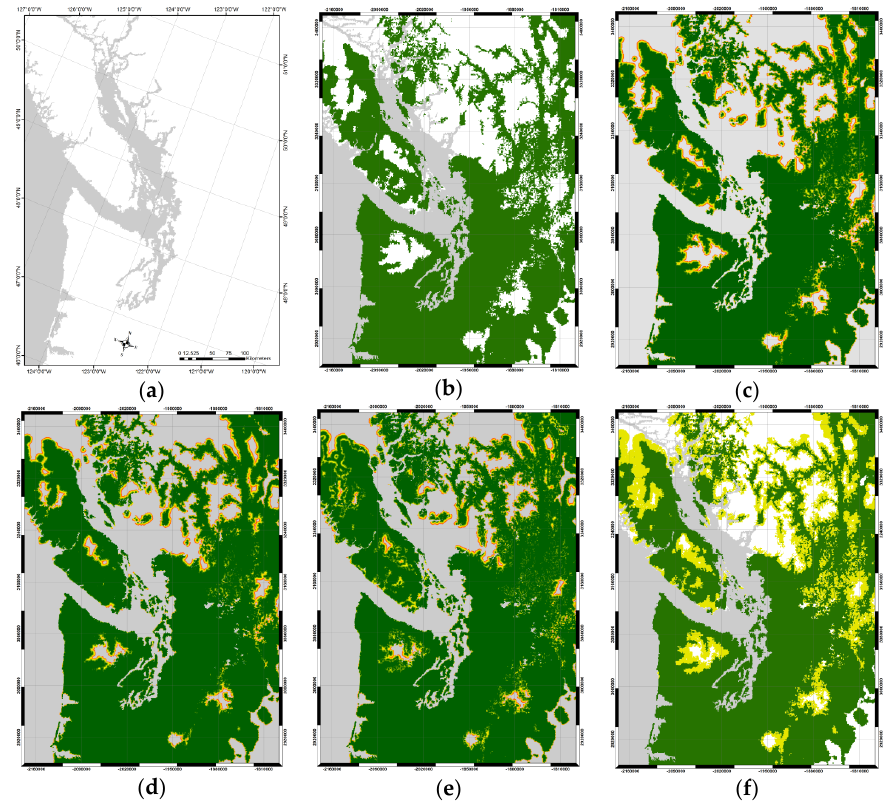
Figure 3. Depiction of the cost distance and impedance functions. ( a ) Coordinates and details of the map subset; ( b ) current distribution of Douglas-fir; ( c ) with the addition of other landscape